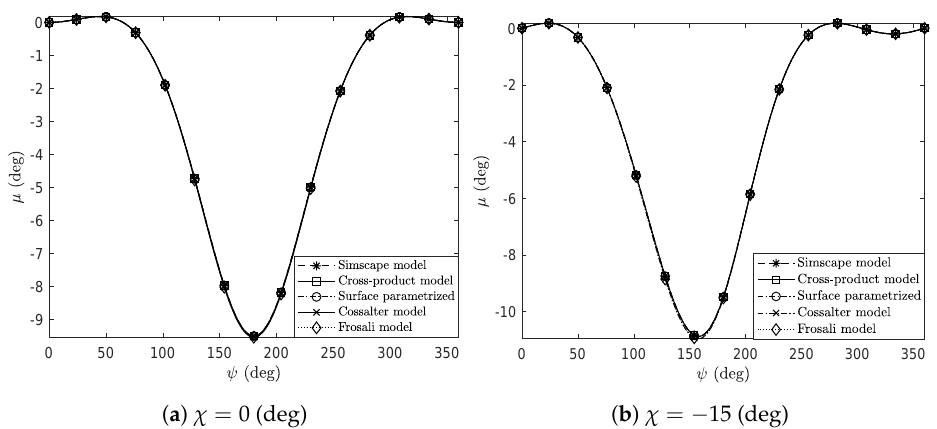
Figure 13. Variation of the rear frame pitch angle for a complete rotation of the vehicle handlebars. ( a ) considers the case of a constant roll angle of the rear frame equal to zero. ( b ) shows the pitch angle variation for a constant roll angle of the rear frame equal to χ = − 15